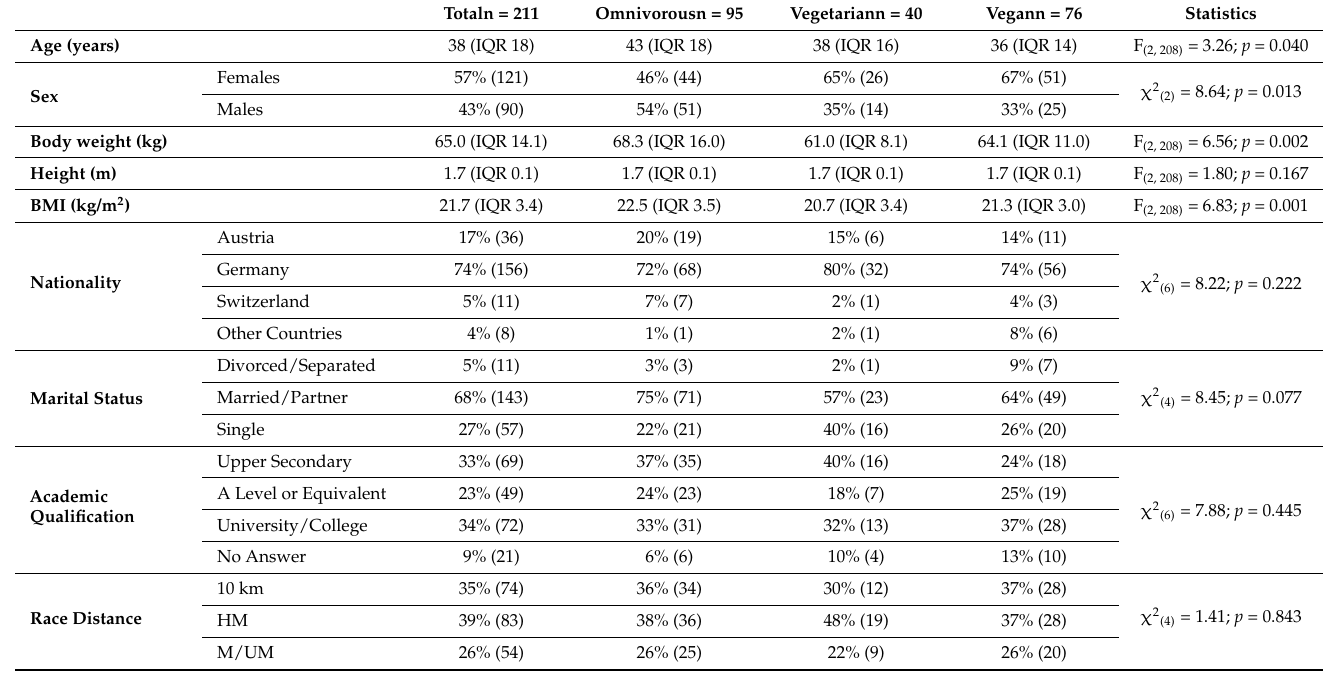
Table 2. Sociodemographic characteristics of the runners by diet